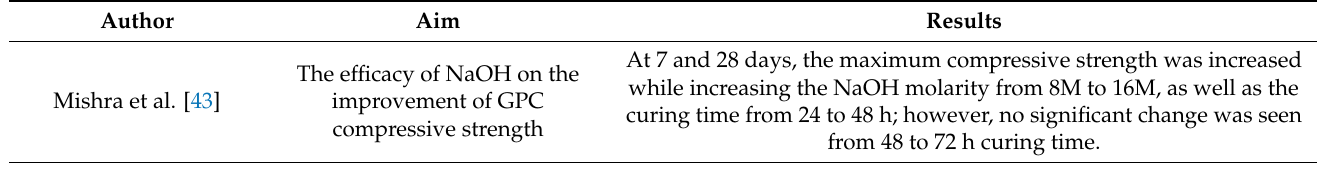
Figure 6. Effect of ( a ) SS/SH ratio; ( b ) recycled concrete aggregate (RCA) replacement on the compressive strength [49]. Table 4. Effect of liquid additives (water-alkaline solution plasticizer) on GPC.